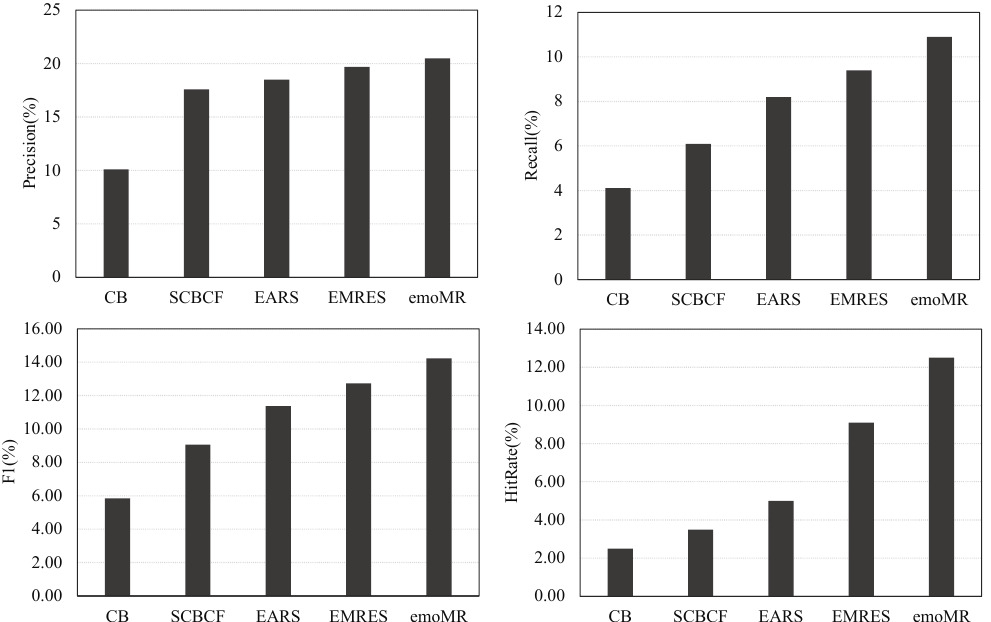
Figure 9. The performance comparison of the methods in the top-10 recommendation